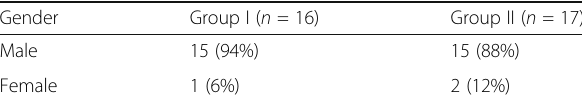
Table 1 Gender distribution